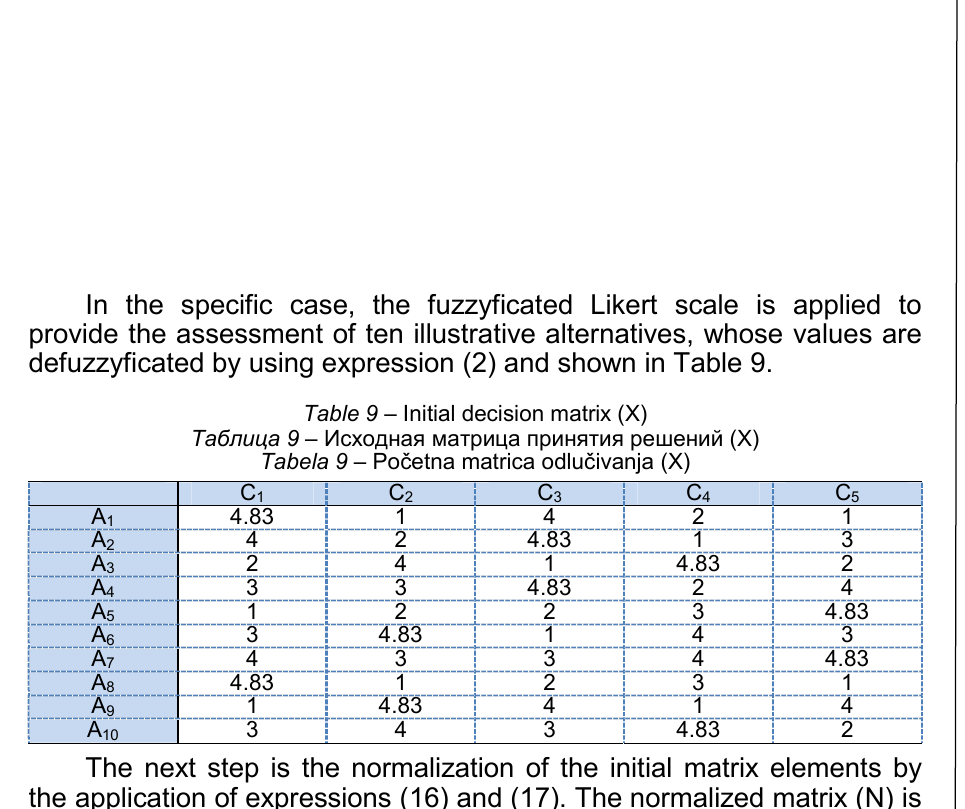
Table 10 – Normalized matrix (N) Таблица 10 – Нормированная матрица (N)